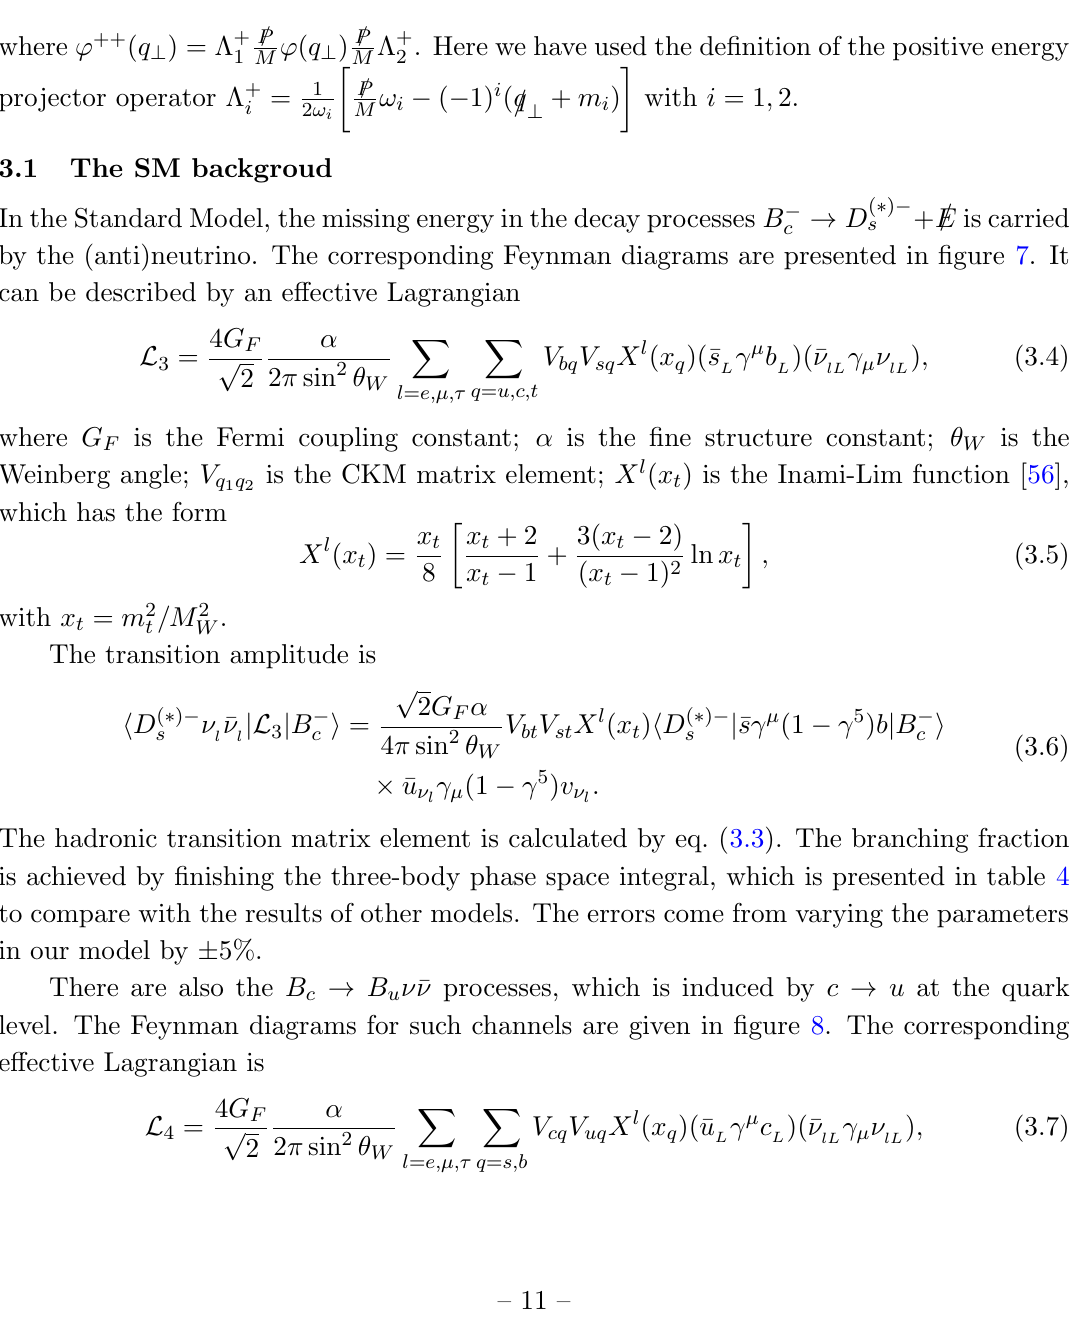
D ( (cid:3) ) (cid:0) s (cid:23) (cid:22) (cid:23) c !